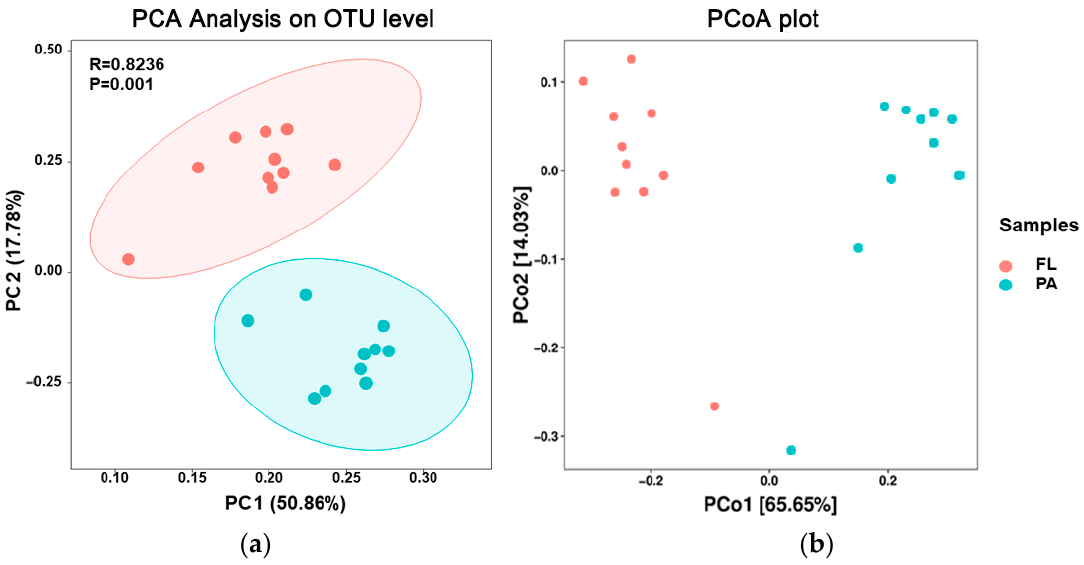
Figure 7. Results of principal component analysis (PCA) ( a ) and principal coordinates analysis (PCoA) ( b ) between PA and FL.